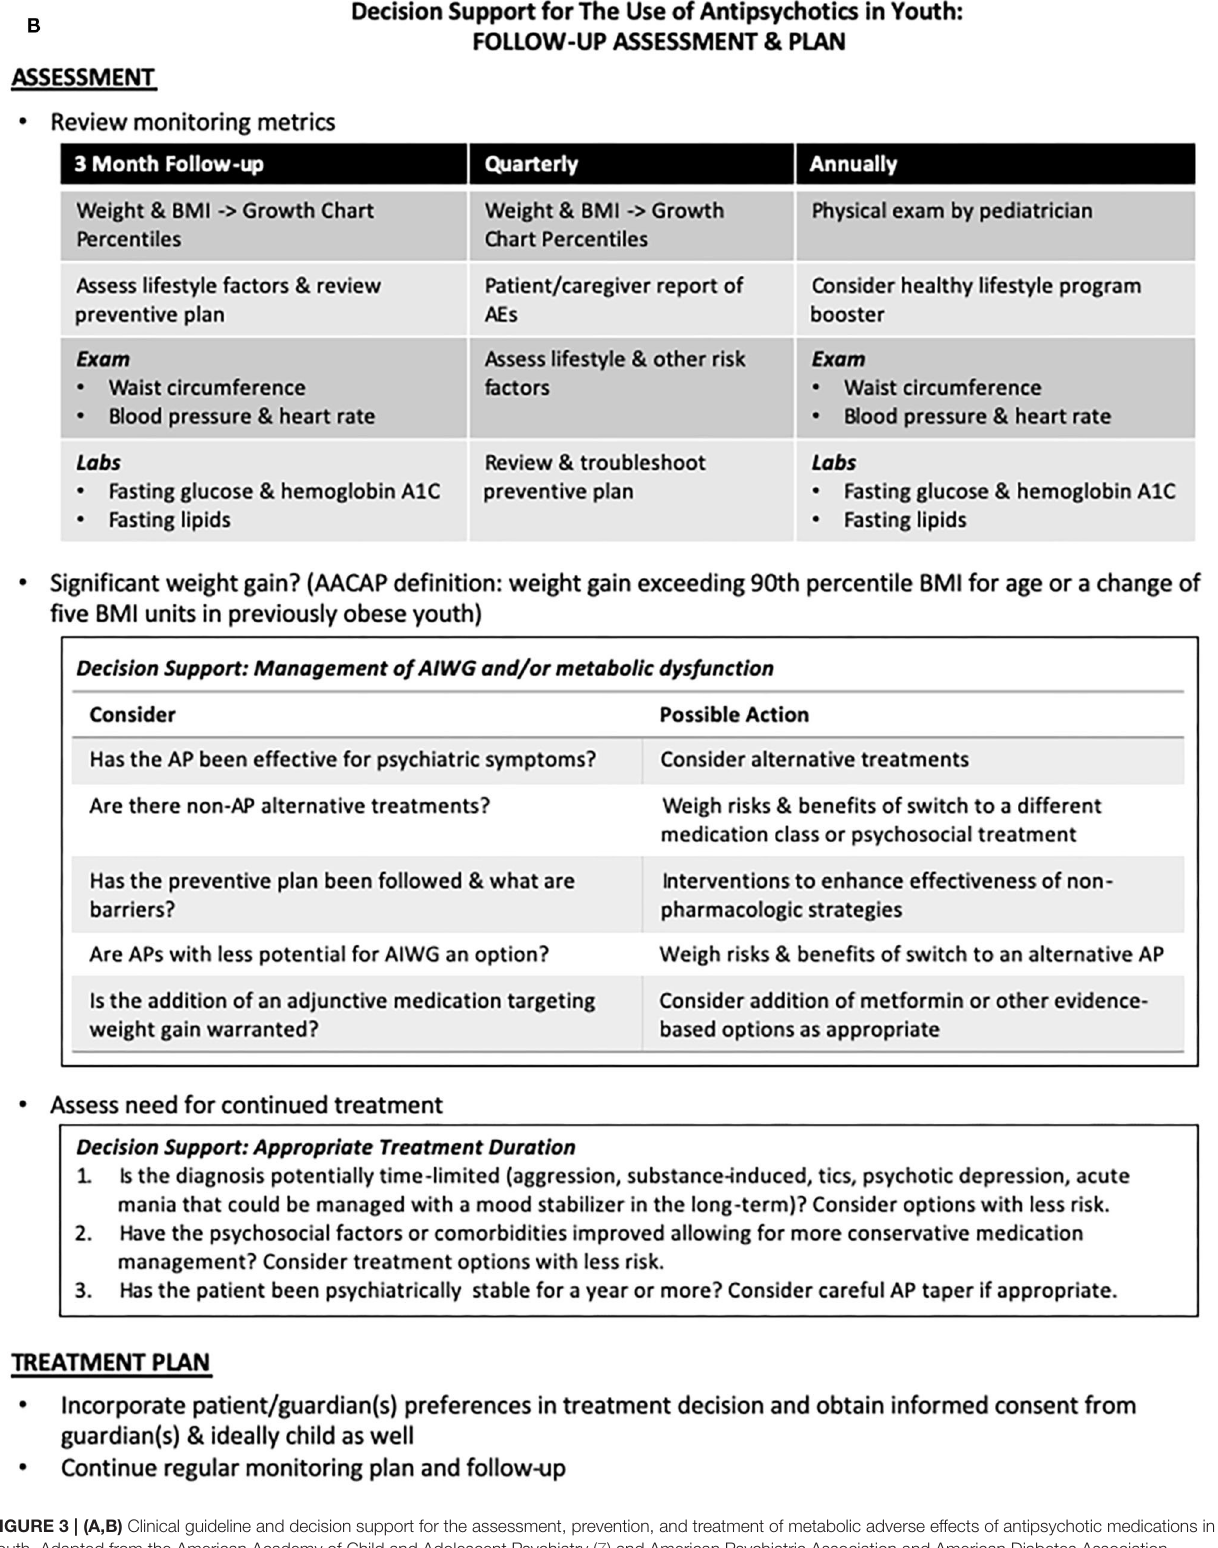
Frontiers in Psychiatry |